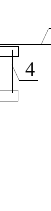
Figure 6. Schematic of FBG stress sensors: 1—FBG; 2—Optic fiber; 3—Cantilever beam; 4—Wire rope; 5—Bourdon tube; 6—pressure ring.